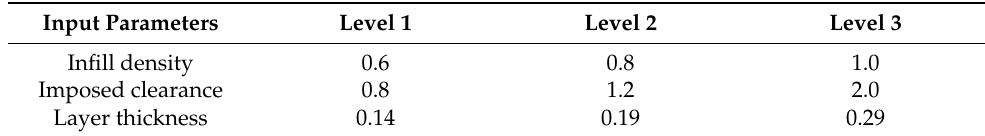
Table 2. The input